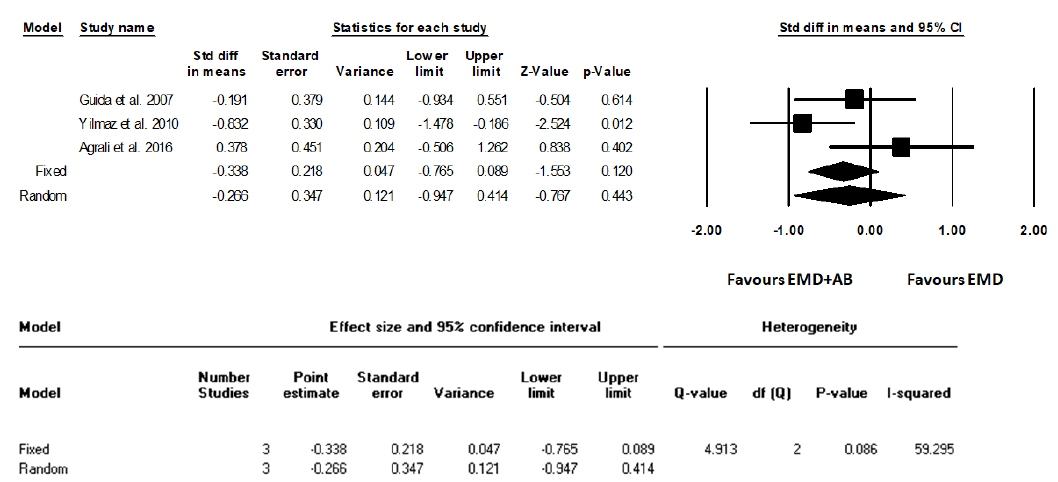
Figure 2. Forest plot from fixed and random effects of meta-analysis evaluating the differences in gain in clinical attachment level (CALgain, mm) after surgical treatment using EMD and autogenous bone or EMD alone (weighted mean difference, 95% CI) with the related heterogeneity analysis.